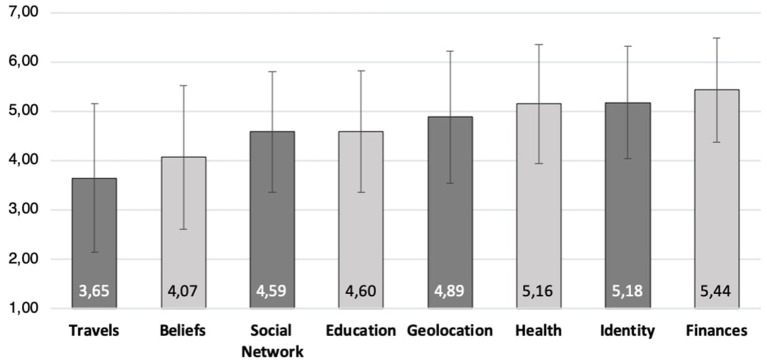
User's reported value for each data type (item average).